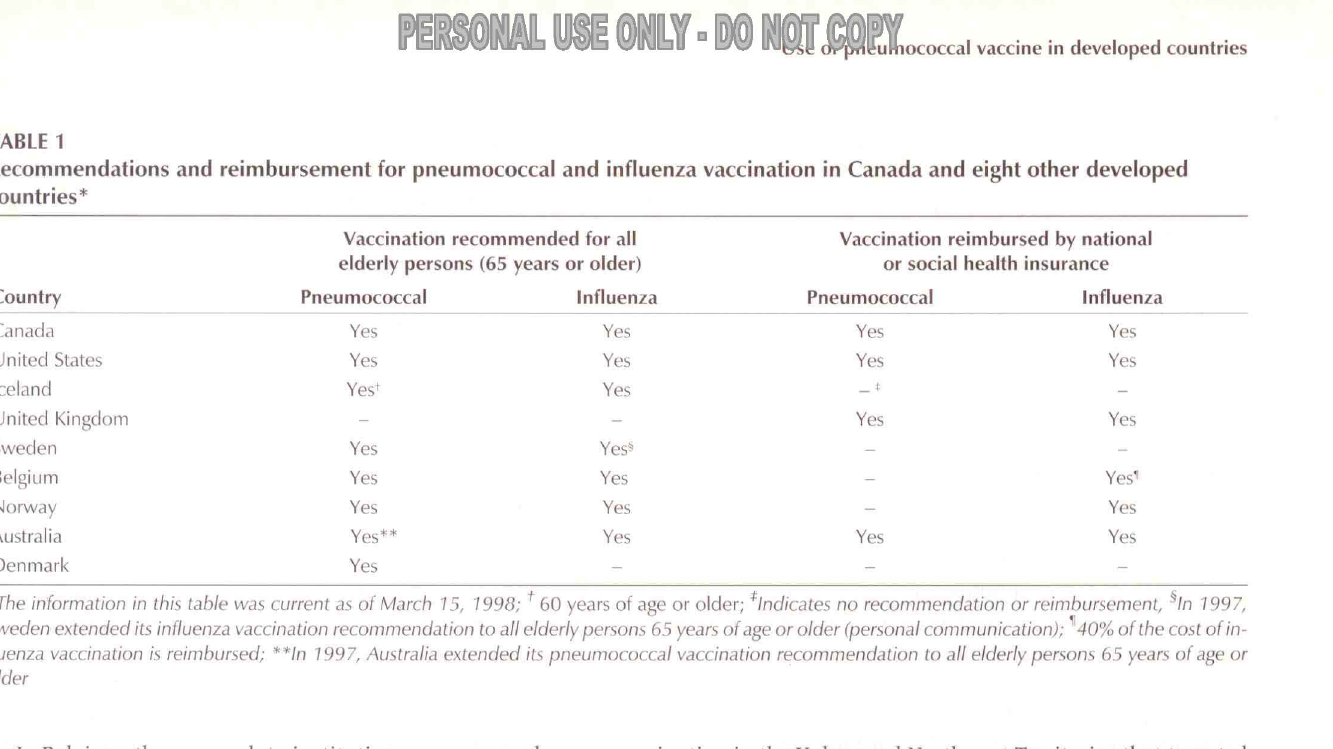
Recommendations and reimbursement for pneumococcal and influenza vaccination in Canada and eight other developed countries* Vaccination recommended for all elderly persons (65 years or